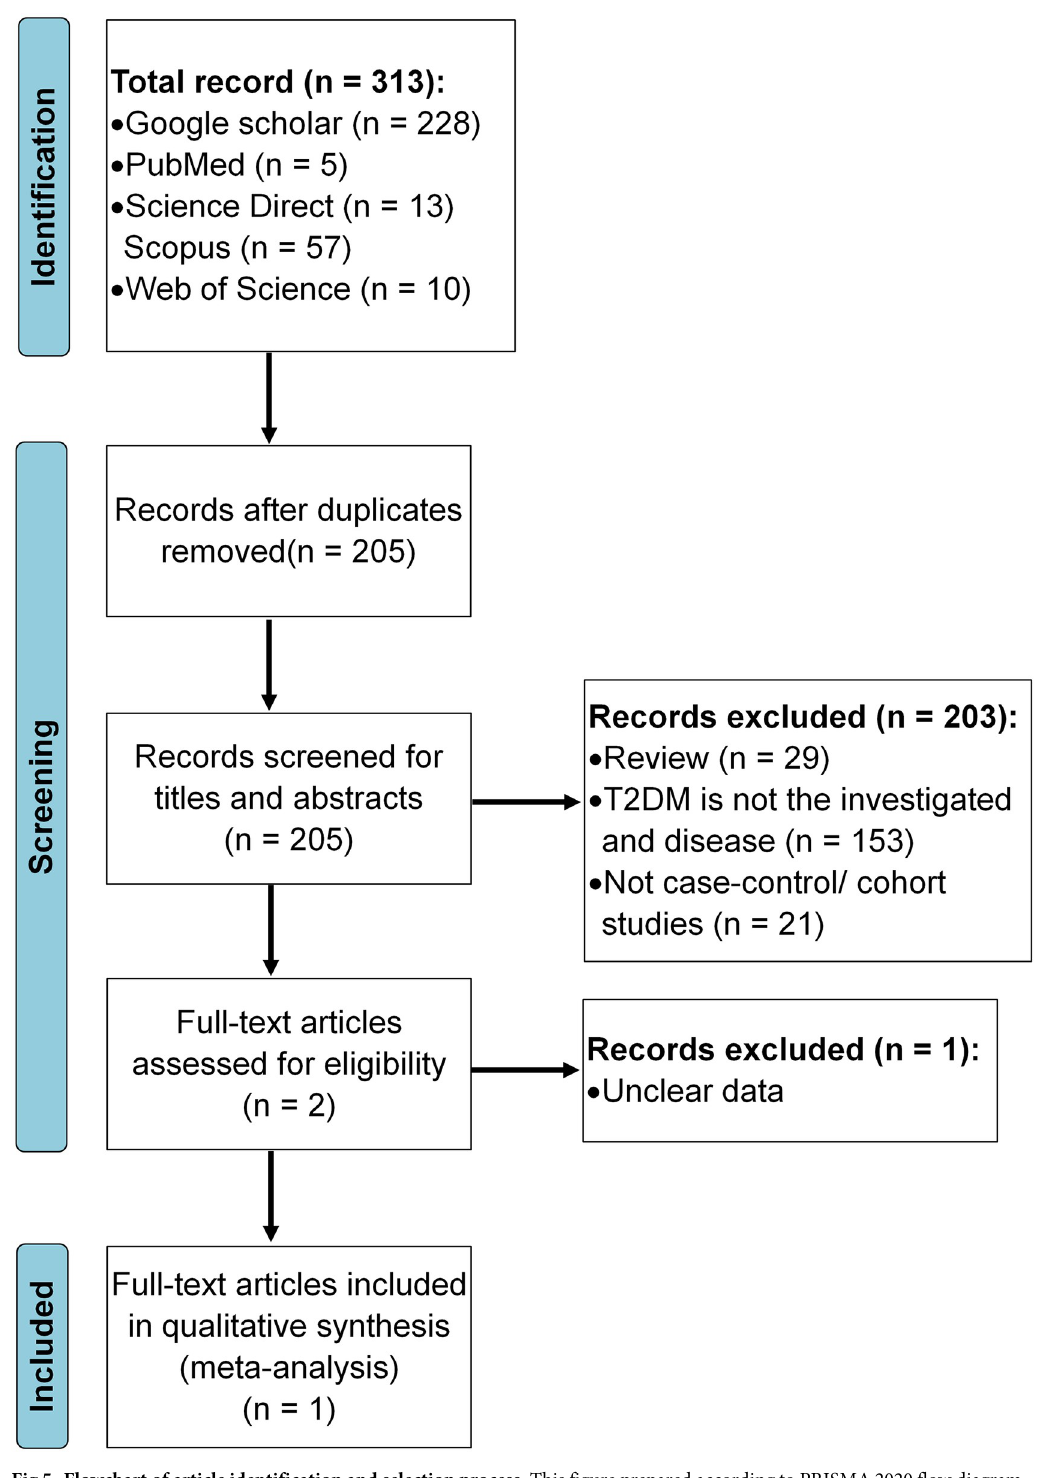
Fig 5. Flowchart of article identification and selection process. This figure prepared according to PRISMA 2020 flow diagram [65].